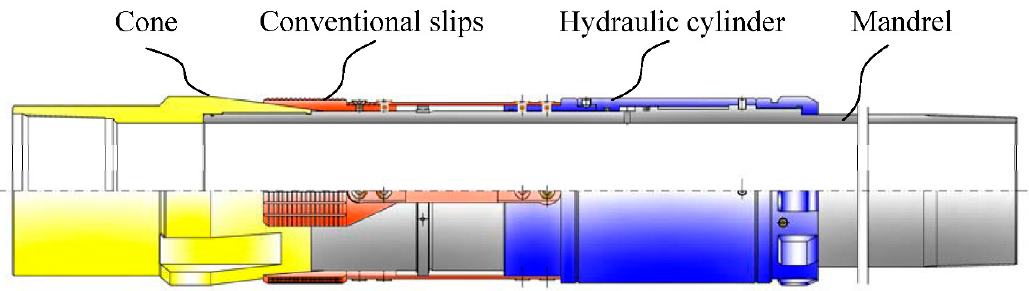
Figure 1. Conventional liner hanger.